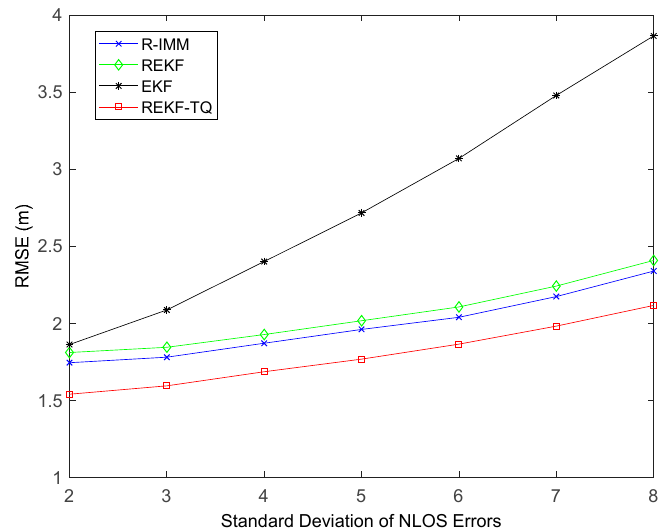
Figure 7. The RMSE versus standard deviation of NLOS errors.